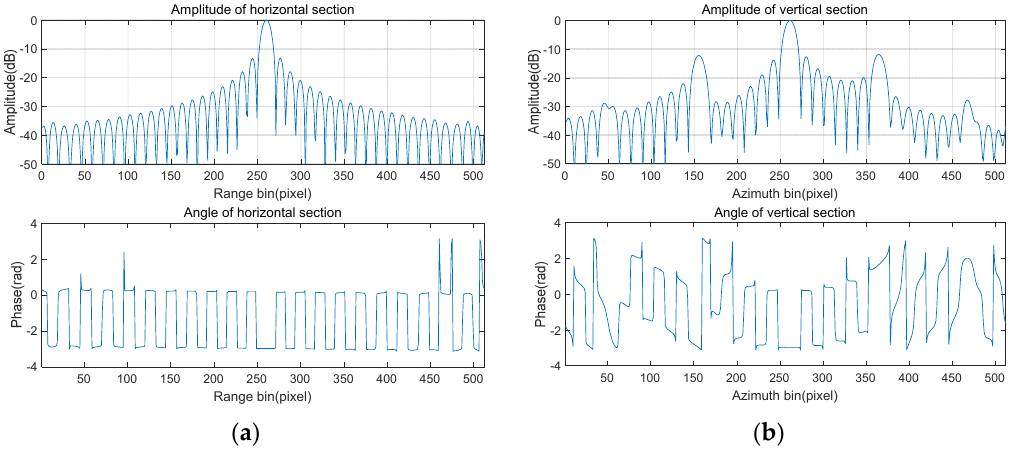
Figure 7. Focusing quality analysis of point target. ( a ) Range; ( b ) azimuth.